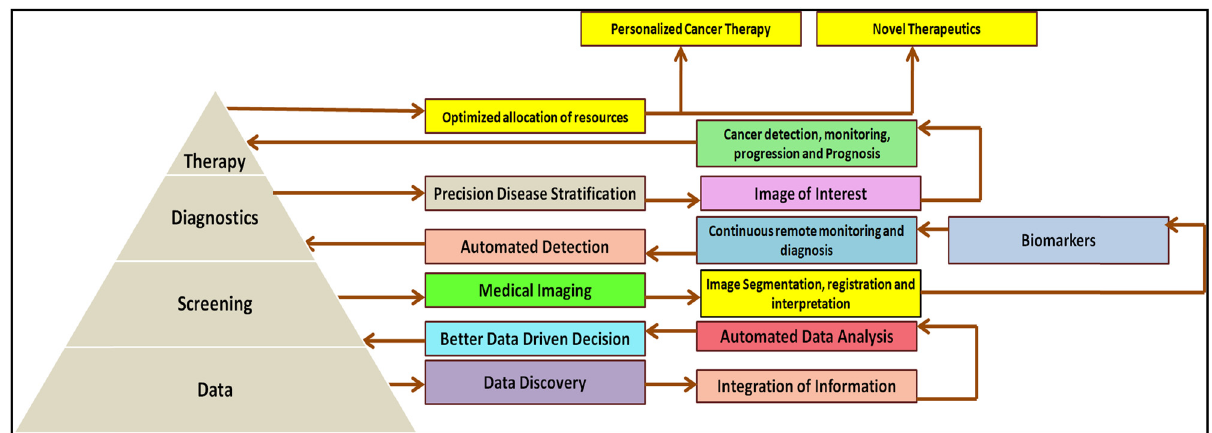
Figure 8: Application of AI in cancer imaging to create better data - driven diagnoses using deep learning